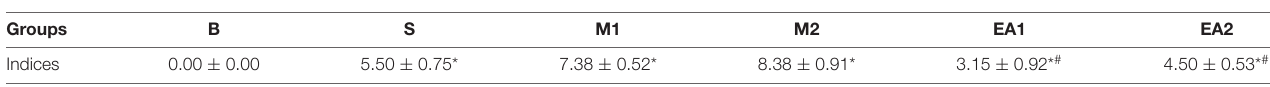
Table 4 . The difference between the other groups and the blank group was significant. Groups M1 and M2 were scored 7.00 and 9.25, respectively, while Group M1 was significantly lower than Group M2. Groups EA1 and EA2 were scored 4.13 and 5.75,